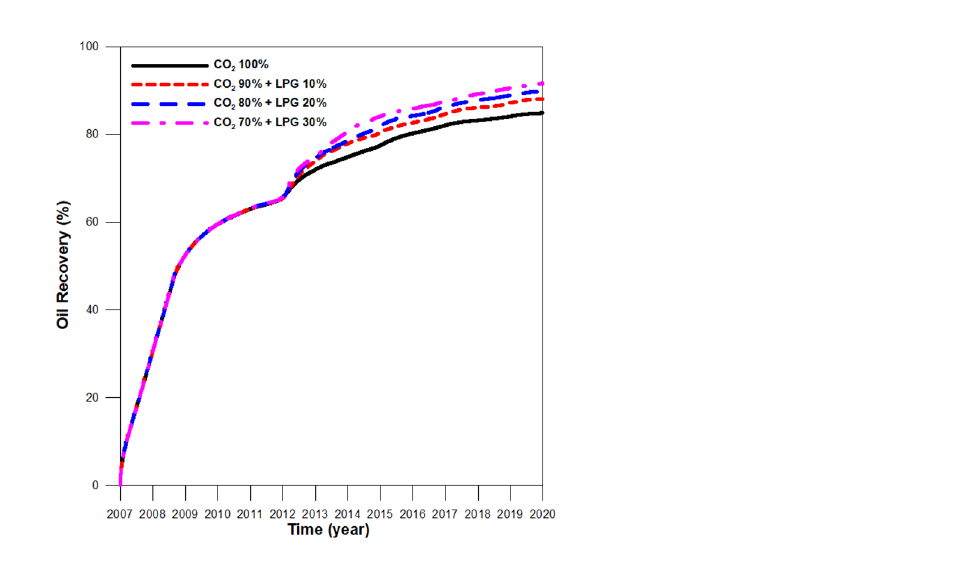
Figure 14. Oil recovery during CO 2 and CO 2 -LPG WAG injection in integrative models at various LPG